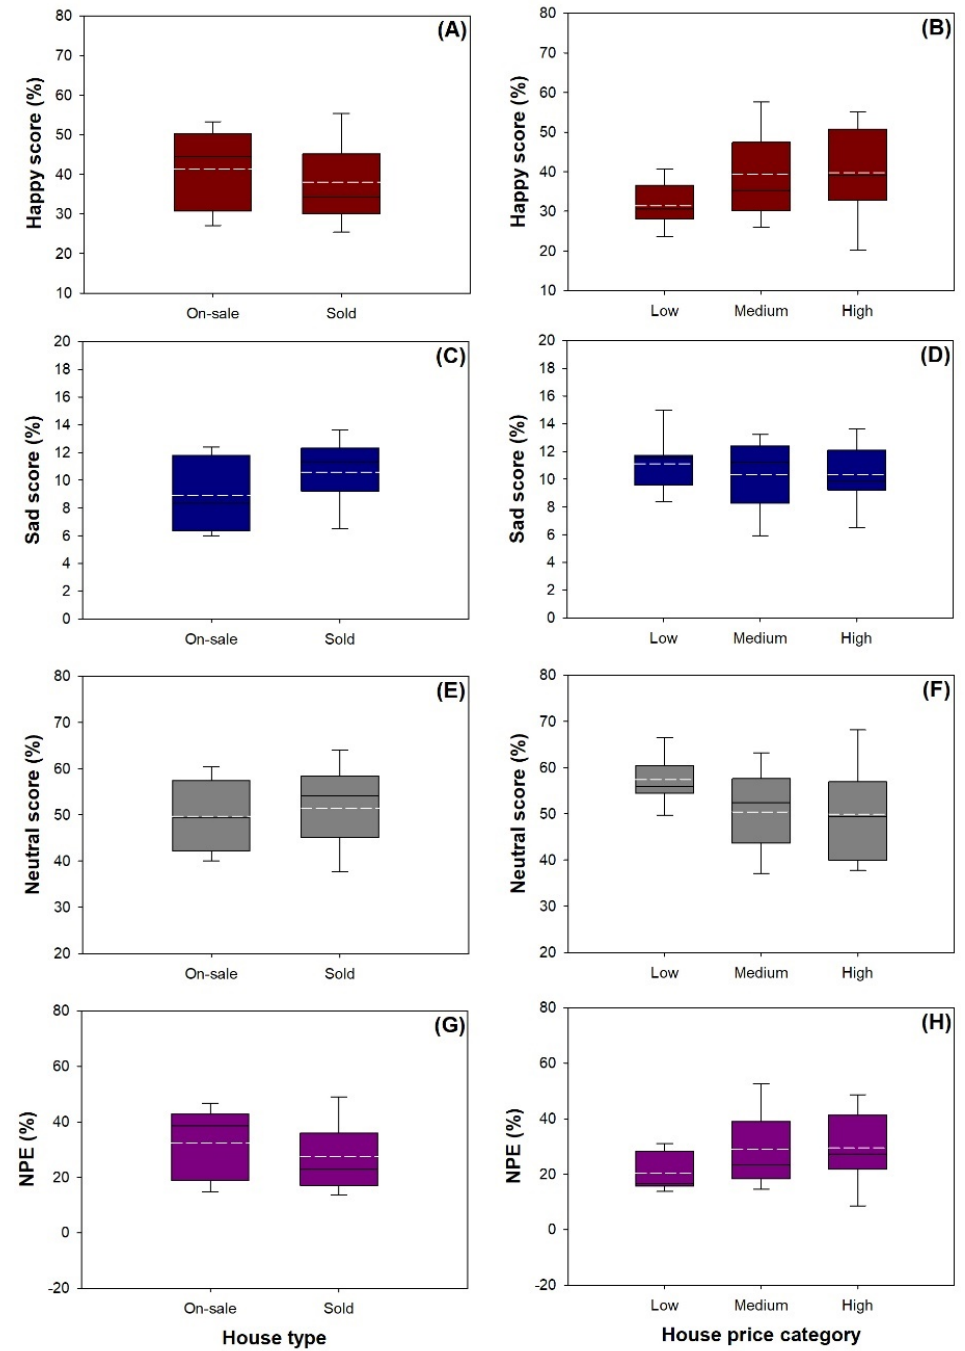
Figure 3. Whisker-box plots happy ( A , B ), sad ( C , D ), and neutral emotional scores ( E , F ) and NPE ( G , H ). A box frames the range of data in 25% (upper) and 75% (lower) quantiles attached to bars marking 5% (upper) and 95% (lower) quantiles. Within-box dash line stands for the level of median level and dashed line for the mean.